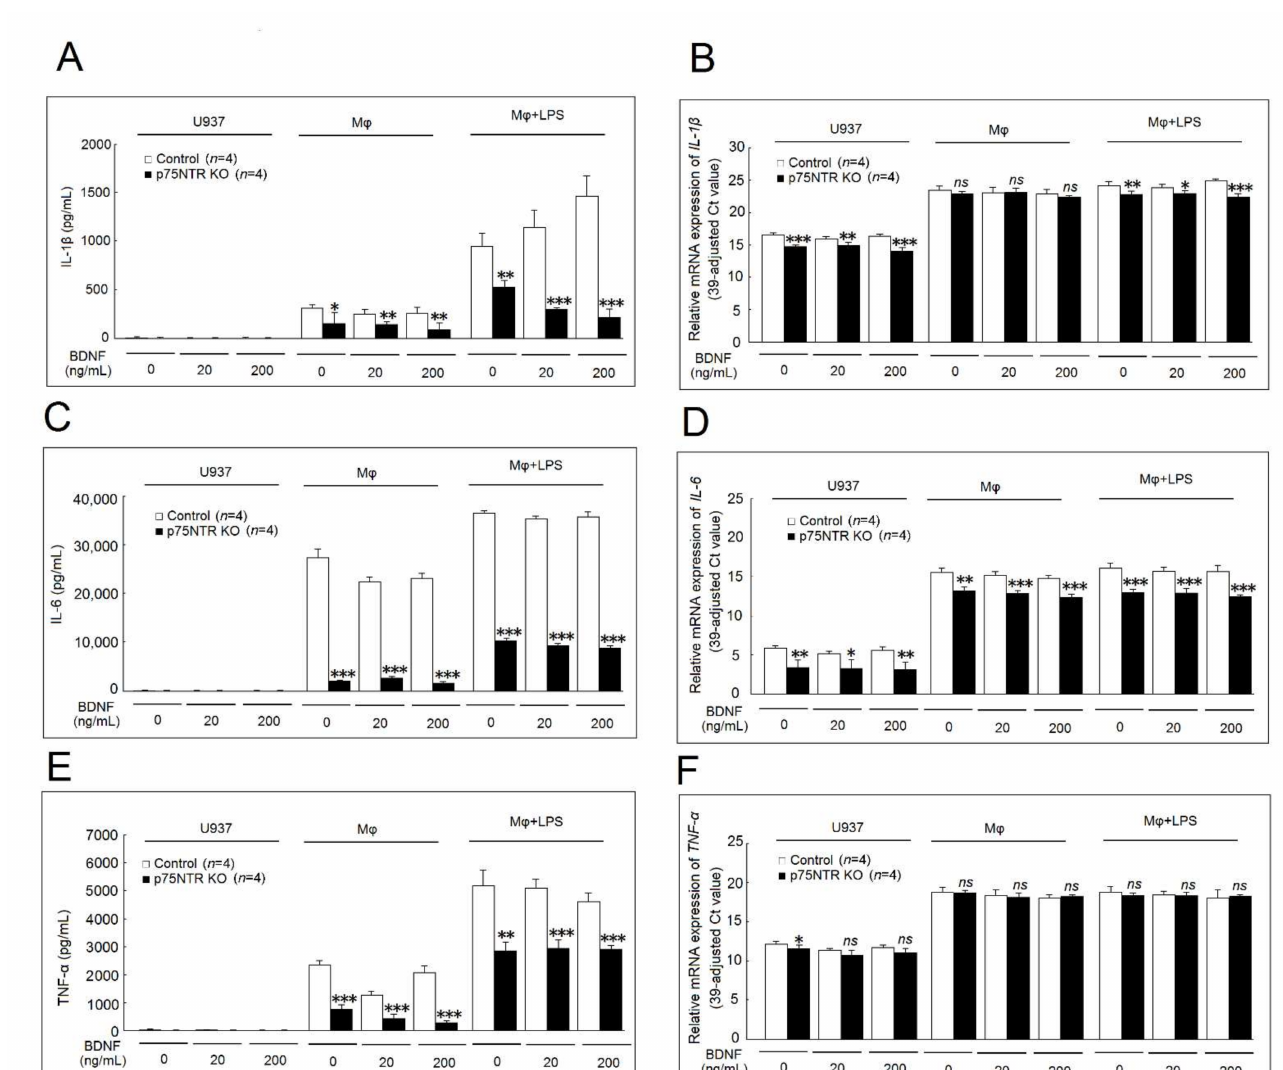
Figure 6. Effects of p75NTR knockout on IL-1 β , IL-6, and TNF- α secretion and mRNA expression. Controls or p75NTR knockout U937 cells were further induced to differentiate into macrophages and then stimulated with LPS with the presence of culture medium, a low concentration of BDNF (20 ng/mL), or a high concentration of BDNF (200 ng/mL) for 48 h (for cytokines secretion) or 4 h (for mRNA expression). The effects of p75NTR knockout on IL-1 β ( A ) secretion and ( B ) mRNA expression. The effects of p75NTR knockout on IL-6 ( C ) secretion and ( D ) mRNA expression. The effects of p75NTR knockout on TNF- α ( E ) secretion and ( F ) mRNA expression (ns, not significant; * p < 0.05; ** p < 0.01; *** p <